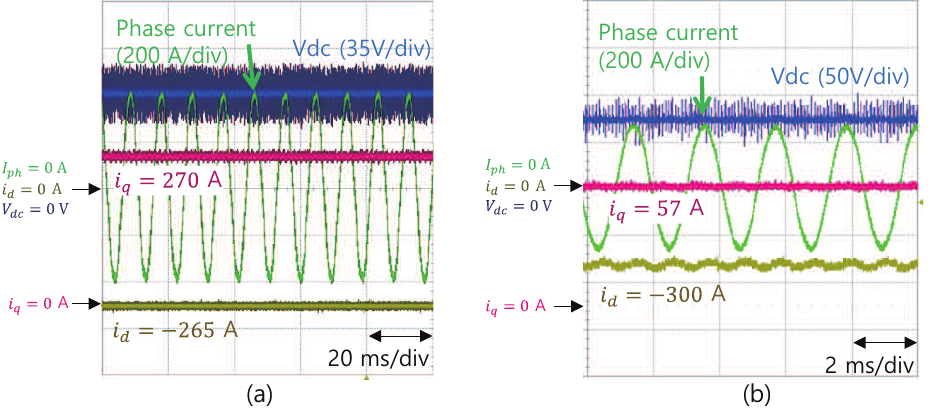
Figure 12. Maximum load experiments: ( a ) 90 Nm at 1600 rpm ( i d = − 265 A, i q = 270 A) and ( b ) 16 Nm at 7000 rpm ( i d = − 300 A, i q = 57 A).